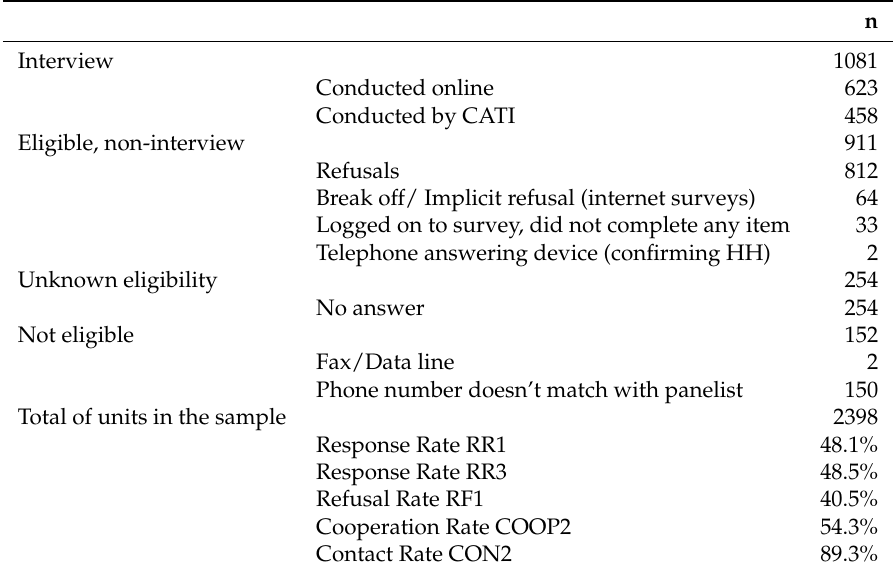
Table 2. Final disposition and Outcome rates for PACIS 2nd Wave Survey (Web +